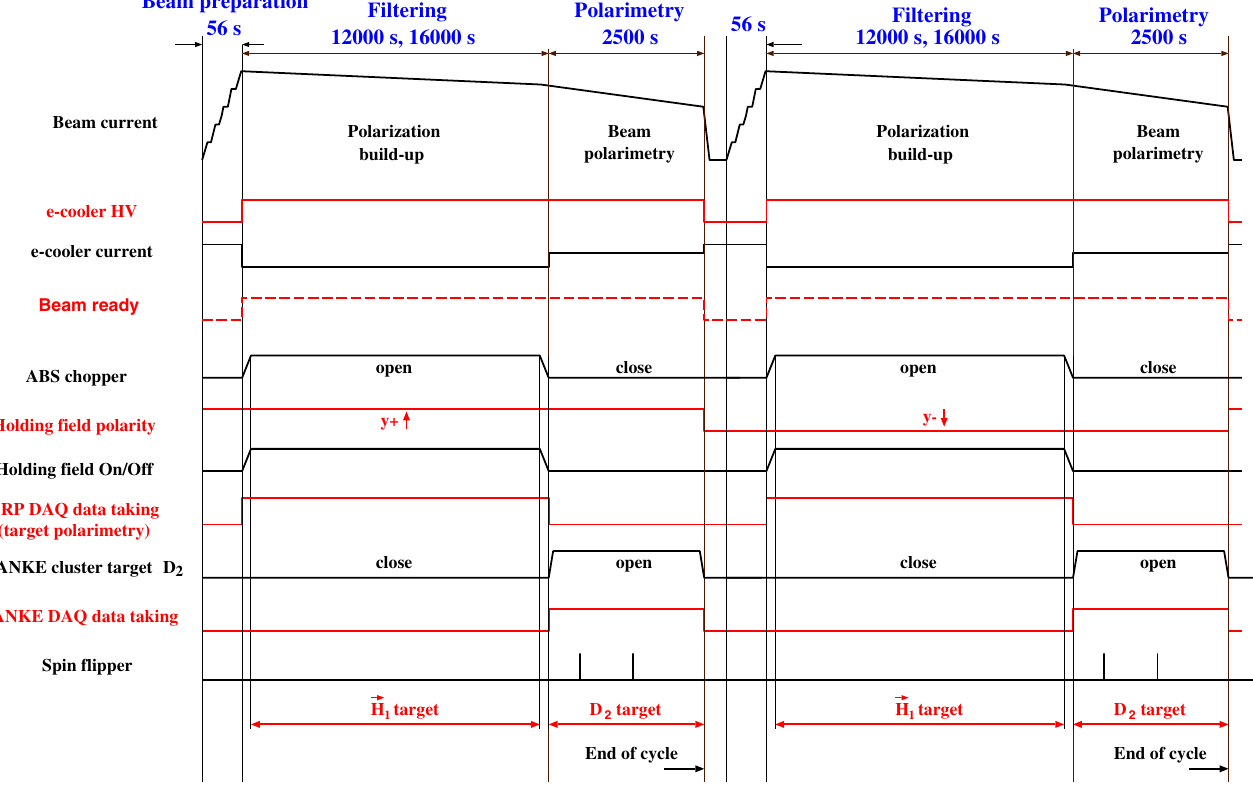
FIG. 24. Sequence of two spin-filtering cycles. During the polarization buildup the polarized internal target and the holding field were switched on, with the ABS chopper open, and the magnetic holding field along the y axis. The BRP was used to measure the target polarization. After spin filtering the ABS chopper was closed and the ANKE cluster target together with the ANKE DAQ were switched on to measure the proton-beam polarization. The electron-cooler current was increased to compensate for larger energy losses due to the thicker cluster target. During the measurement period the beam polarization was flipped several times to minimize systematic effects. The holding field polarity was reversed after each spin-filtering